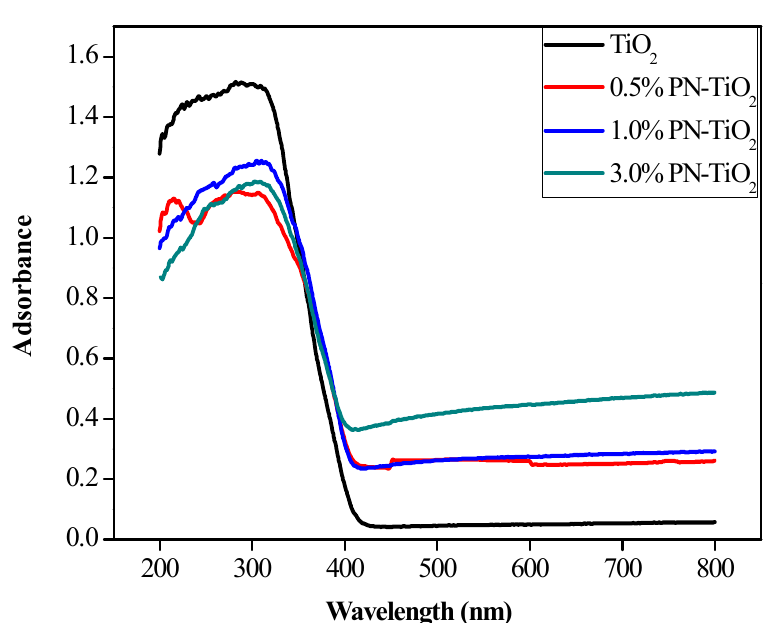
Figure 4. XRD pattern of TiO 2 .